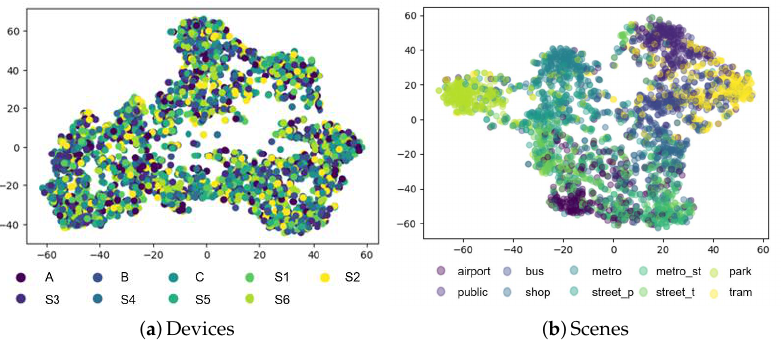
Figure 1. t-SNE embedding visualization results. ( a , b ) illustrate the expressiveness of the baseline classifying devices and scenes, respectively. Color dots represent the